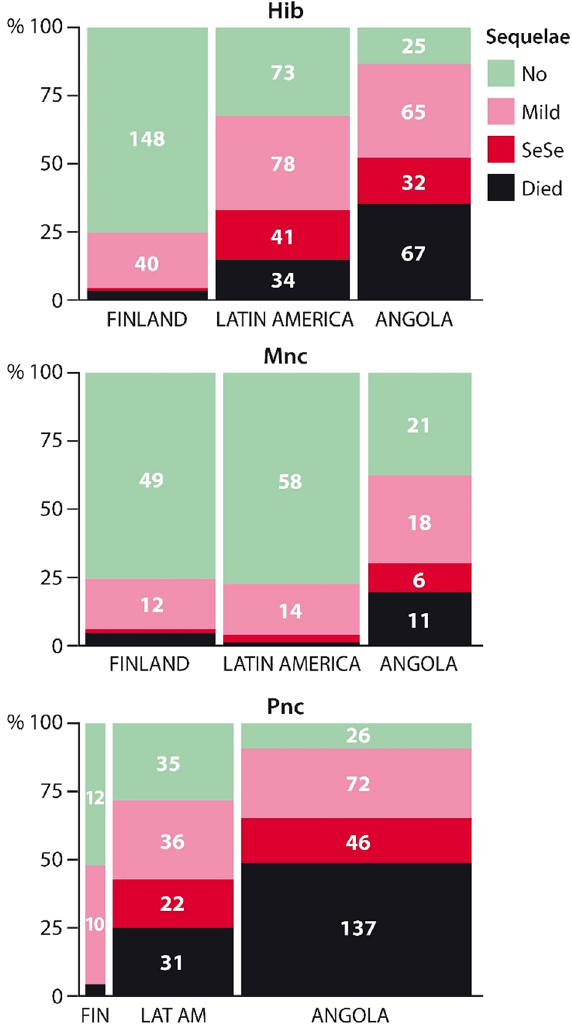
Figure 3. Outcomes of childhood bacterial meningitis according to the main etiology and the study site. Pnc Streptococcus pneumoniae , Others denotes a group comprising mainly Gram-negative rods, Mnc Neisseria meningitidis , Hib Haemophilus influenzae type b. Mild and severe sequelae (SeSe) explained in